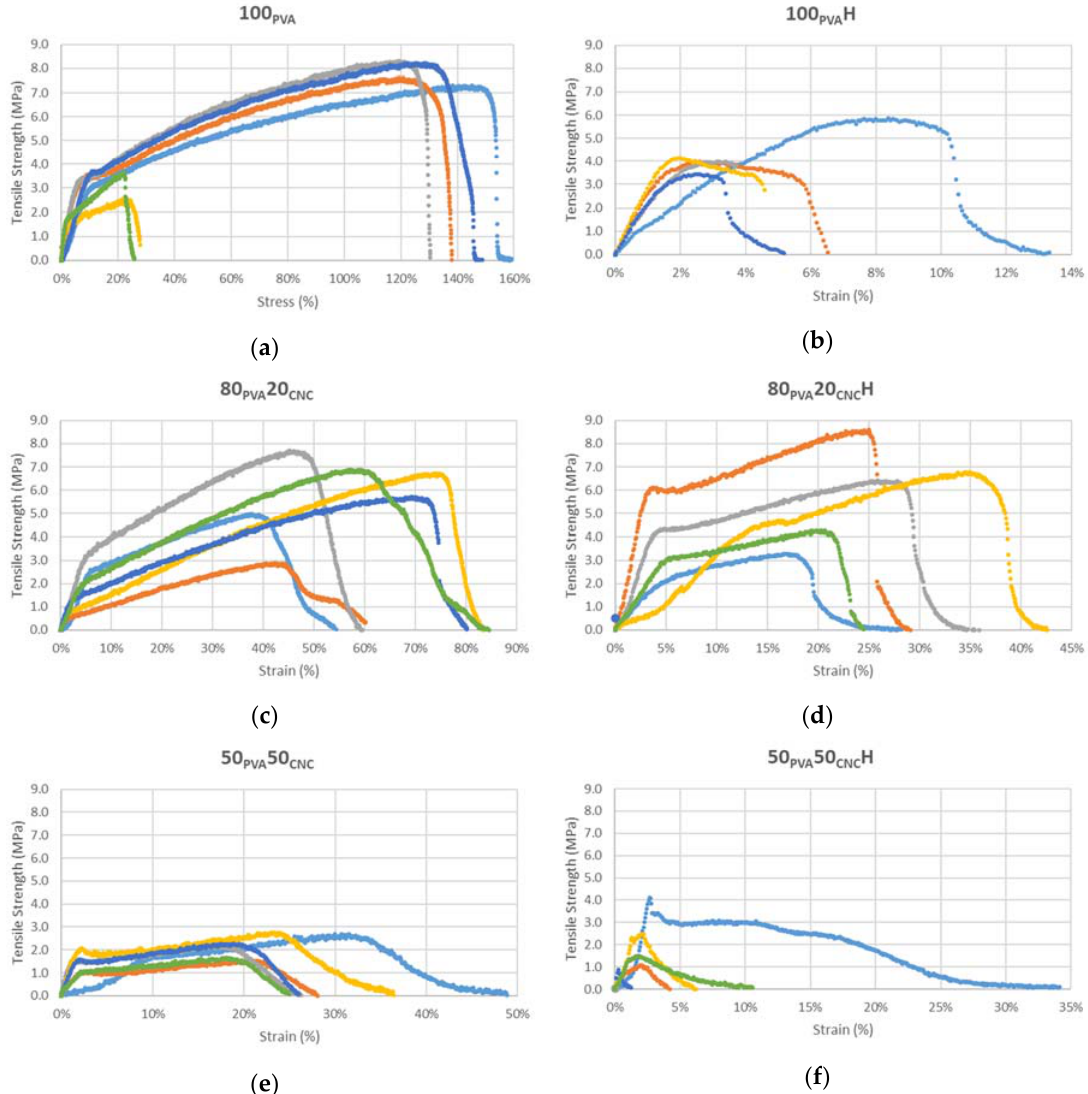
Figure 8. Stress-strain curves for 100 PVA ( a , b ), 80 PVA 20 CNC ( c , d ) and 50 PVA 50 CNC ( e , f ) tensile strength samples. Each sample group has six samples (with the exception of 100 PVA ), and heat treated samples are labeled with an (H). Colors are used to differentiate between individual samples within each group category.